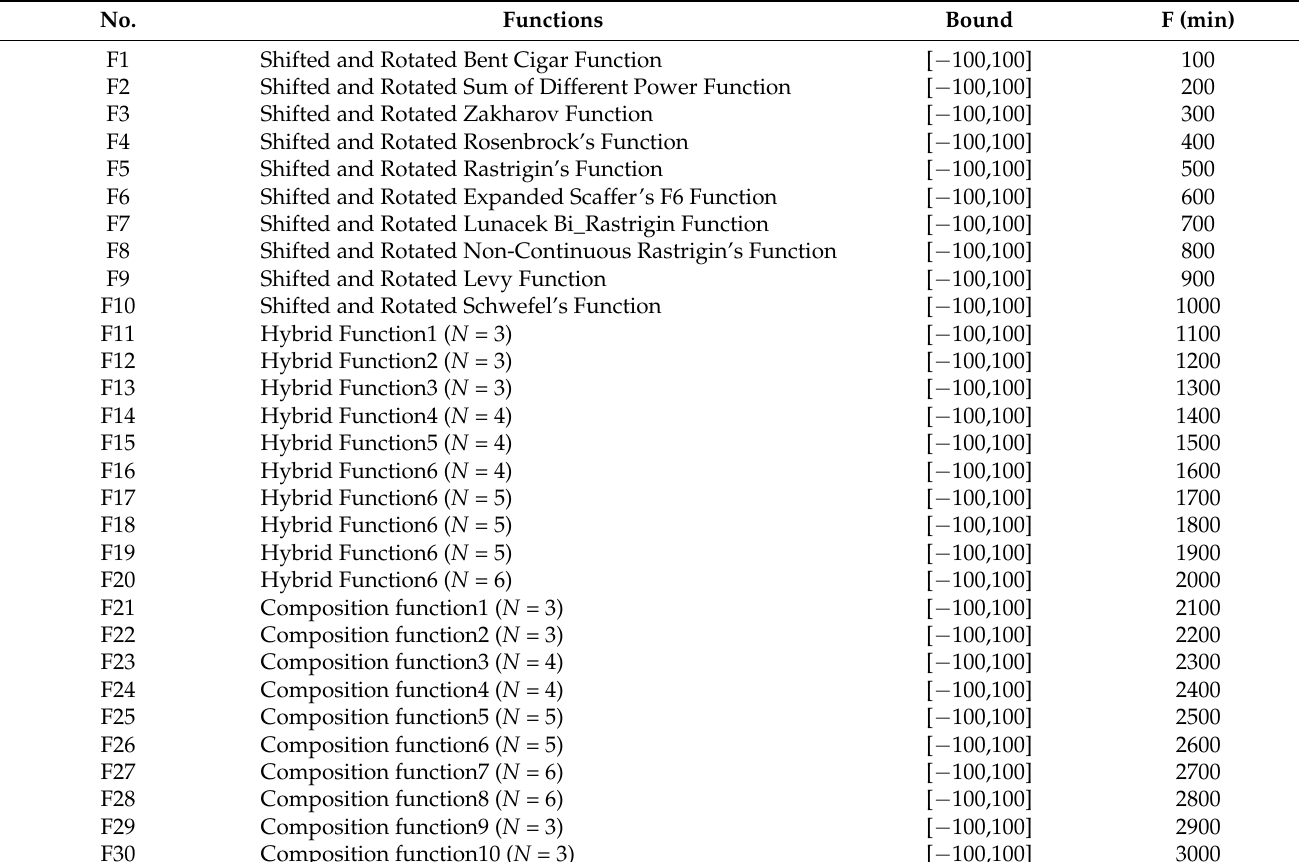
Table 1. Description of the CEC2017